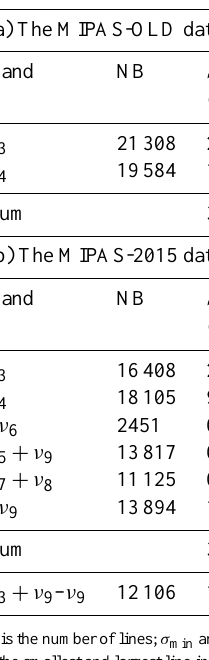
Table 3. HNO 3 line parameters in the 7.6µm region.